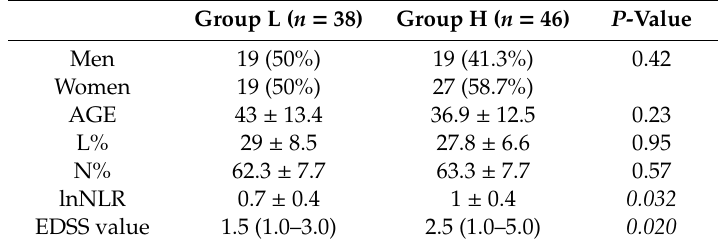
Results are expressed as mean ± SD, median (IQR) and No. (%). IQR = interquartile range; SD = standard deviation. Abbreviations: EDSS, Expanded Disability Status Scale; L, lymphocytes, N, neutrophils; ln-NLR, logarithmic-neutrophils / lymphocyte ratio.